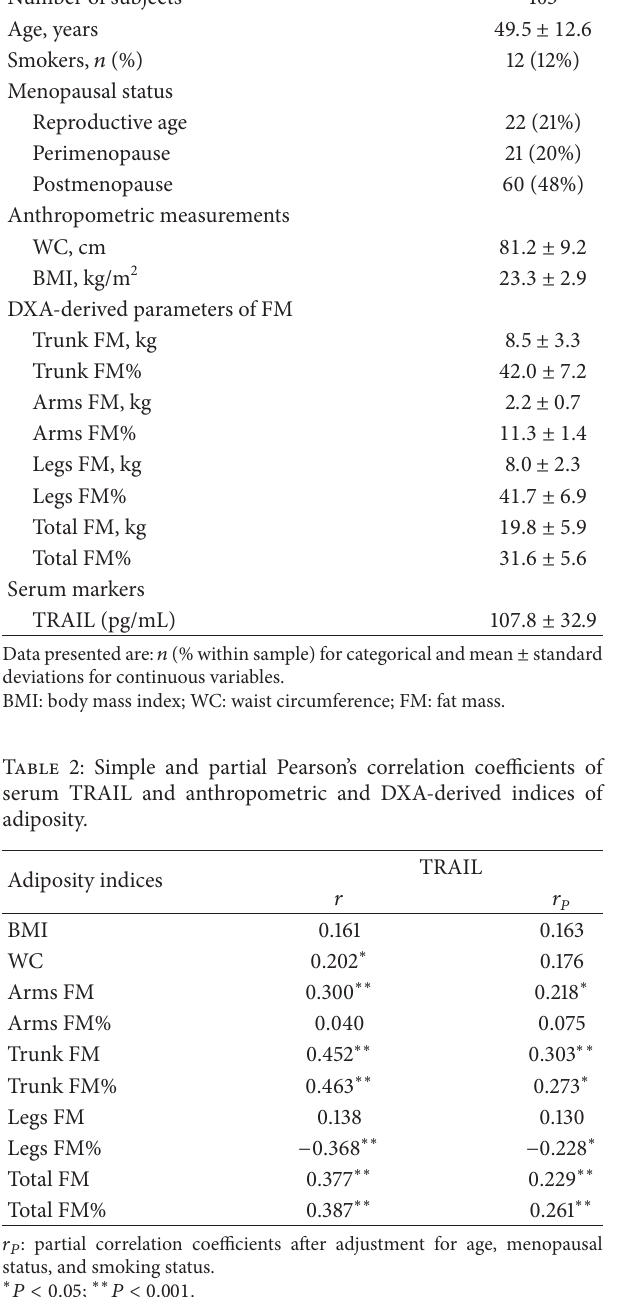
Table 3: Partial correlation coefficients of serum TRAIL levels and selected DXA-derived regional FM